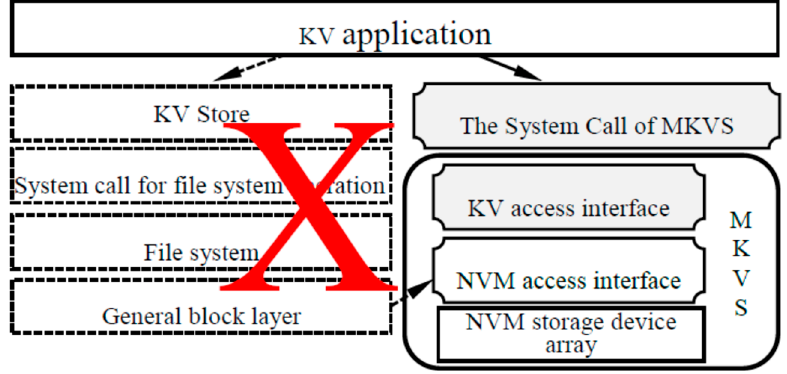
Figure 2. Schematic diagram of the MKVS access interface.